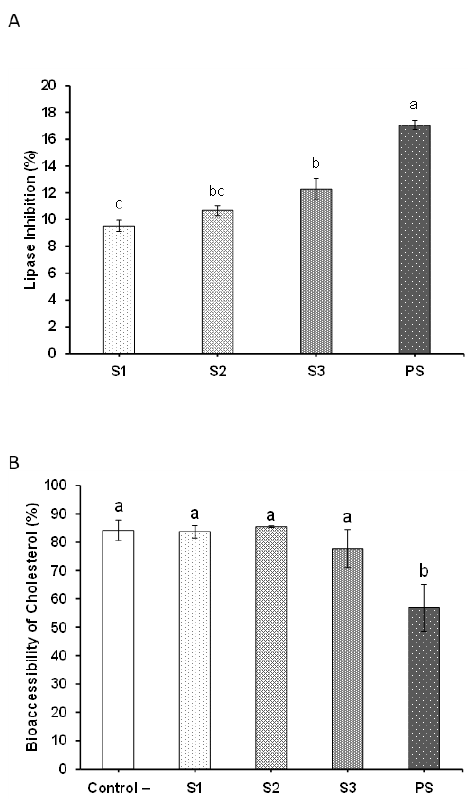
Figure 7. ( A ) E ff ect of S1, S2, S3, and PS extracts (at 0.75 mg/mL) on the inhibition of pancreatic lipase enzyme (%) under simulated intestinal conditions. ( B ) Bioaccessibility of cholesterol (%) after gastrointestinal digestion of cholesterol in absence (Control − ) and presence of S1, S2, S3, and PS extracts at 1 mg/mL. Mean values with di ff erent le tt ers (a–c) are signi fi cantly di ff erent if p ≤ 0.05.